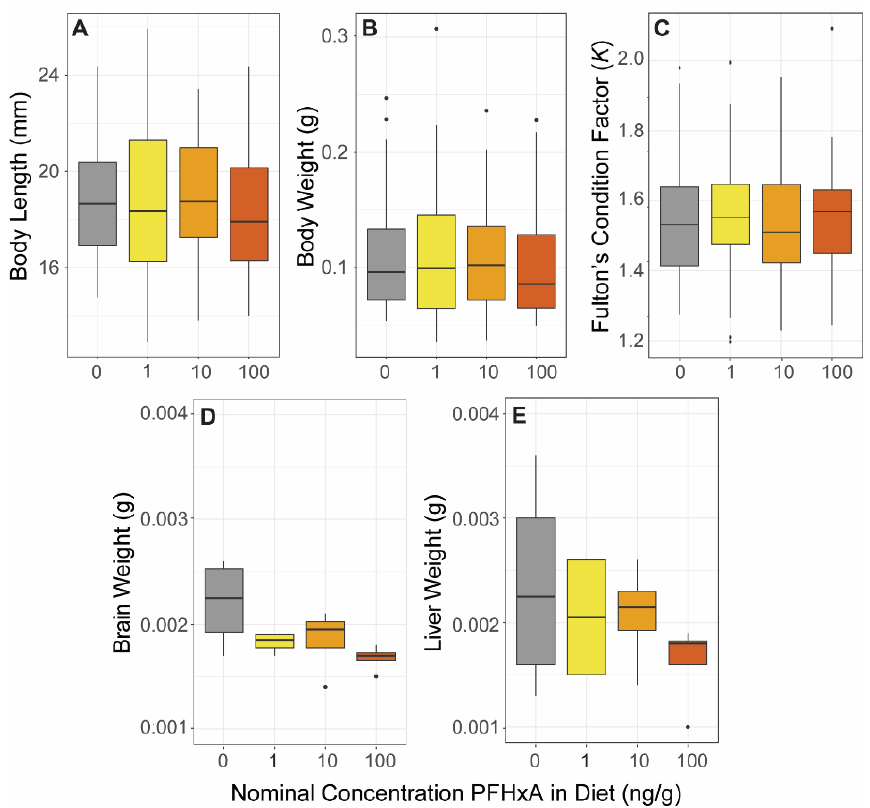
Figure 2. Morphometrics. At 60 dpf, following dietary exposure, zebrafish body length ( A ), weight ( B ), and Fulton’s Condition Factor K ( C ) were measured ( n = 36), as well as average weight ( n = 4) of 8 pooled brains ( D ) or 8 pooled livers ( E ). No significant differences between exposure groups were observed.